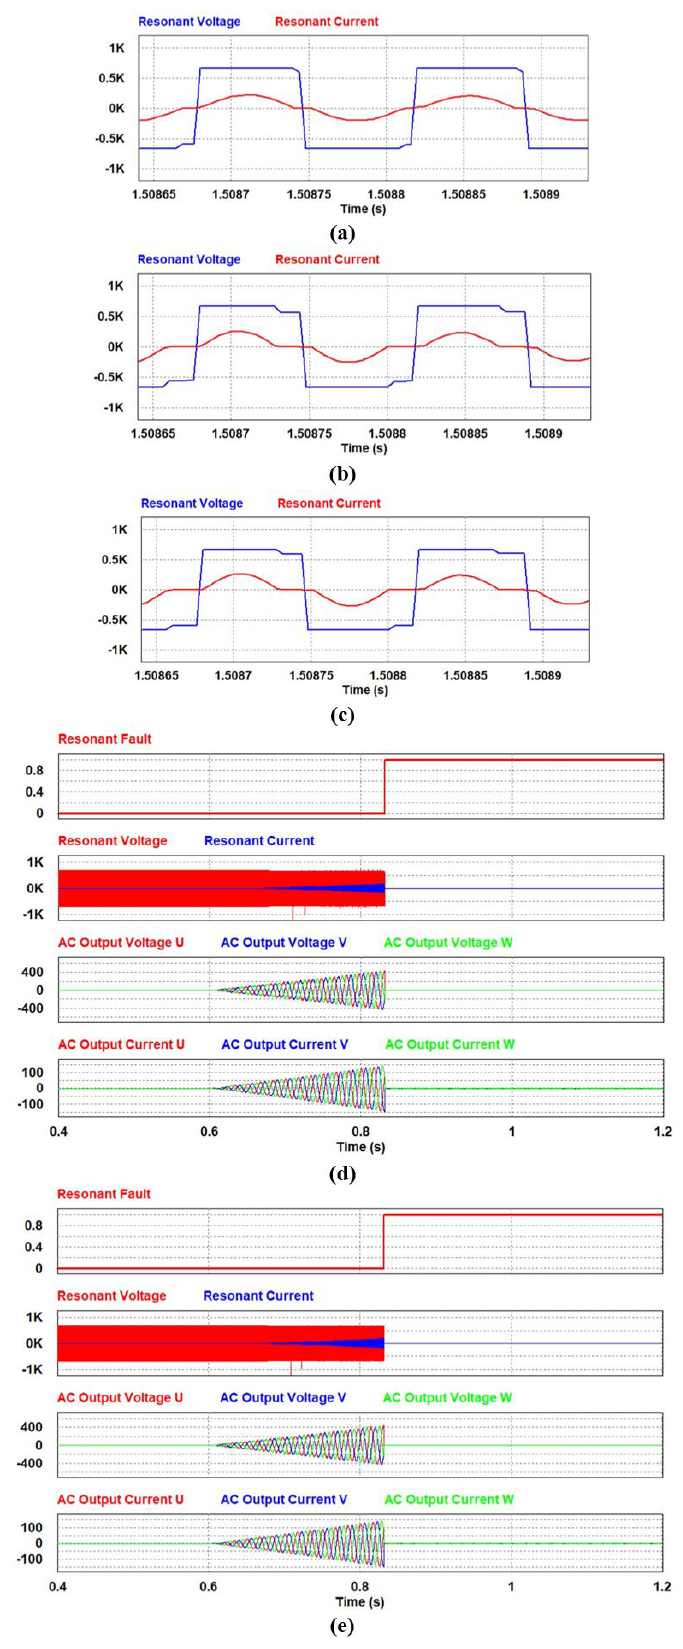
Figure 20. Simulation results of resonant destruction